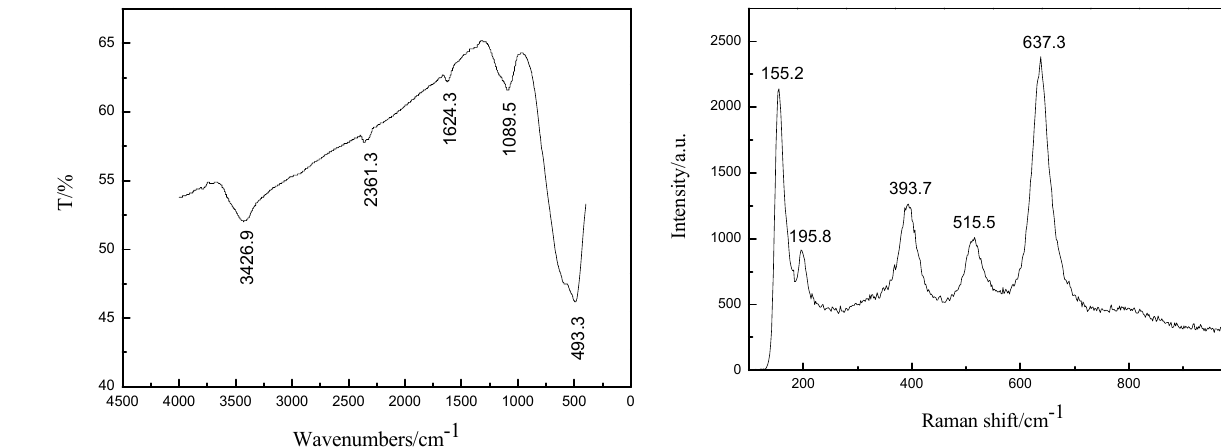
Figure 5. FT-IR spectra of titania slag.